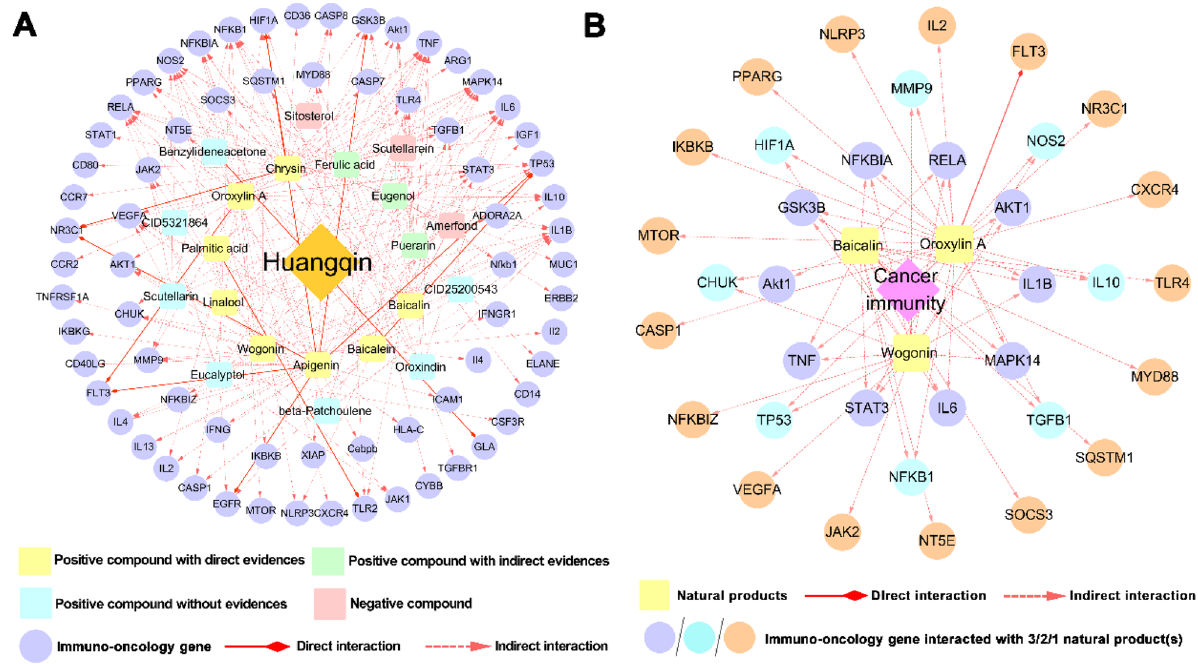
Figure 7. Compound-target (C-T) network of Huangqin ( Scutellaria baicalensis Georgi ) in cancer immunotherapy. ( A ) C-T network for 204 interactions connecting 21 compounds of Huangqin and 66